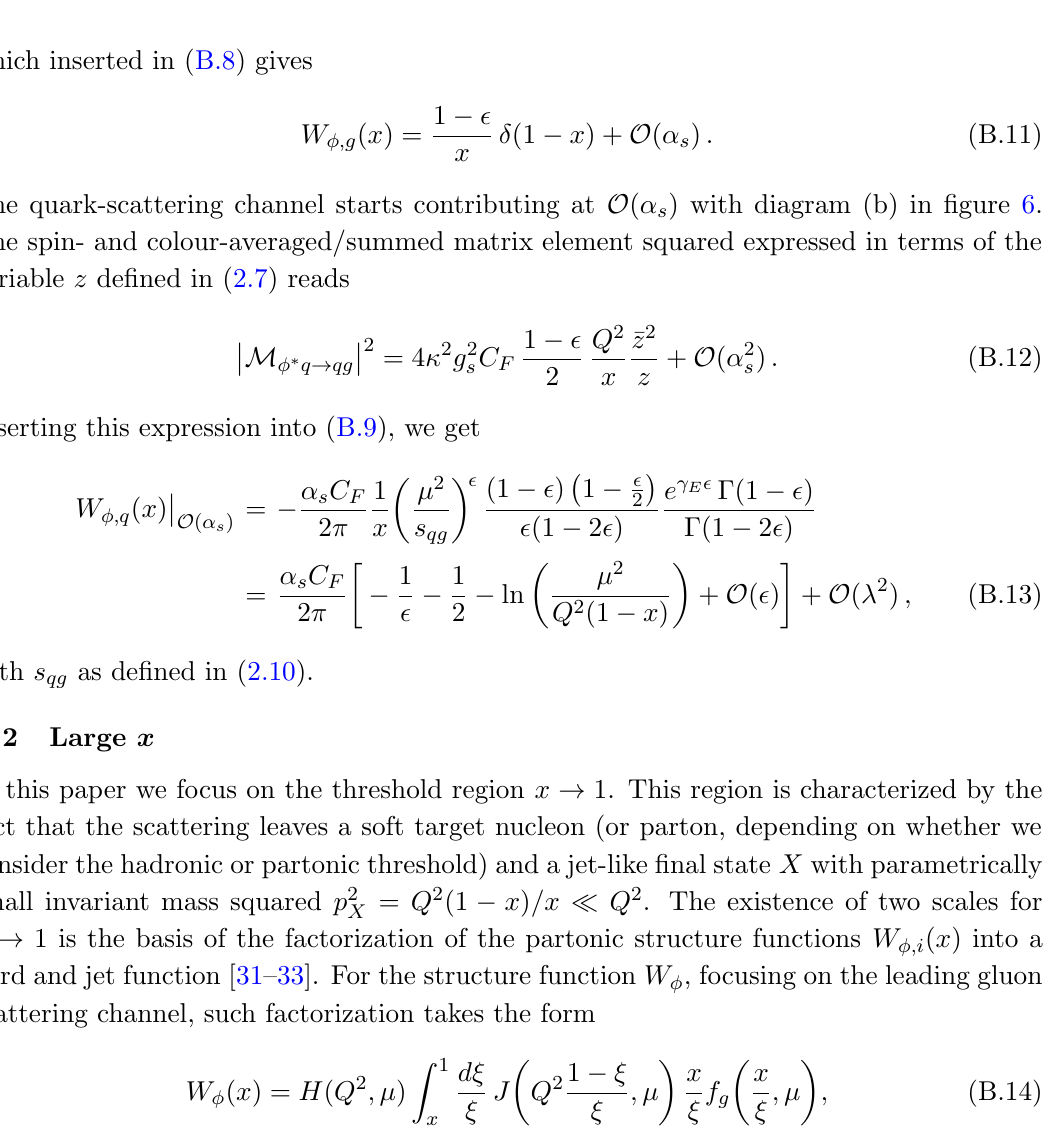
Figure 6 . Partonic contribution to DIS with scalar exchange: (a) LO diagram; (b) NLO contribu- tion in the quark-gluon